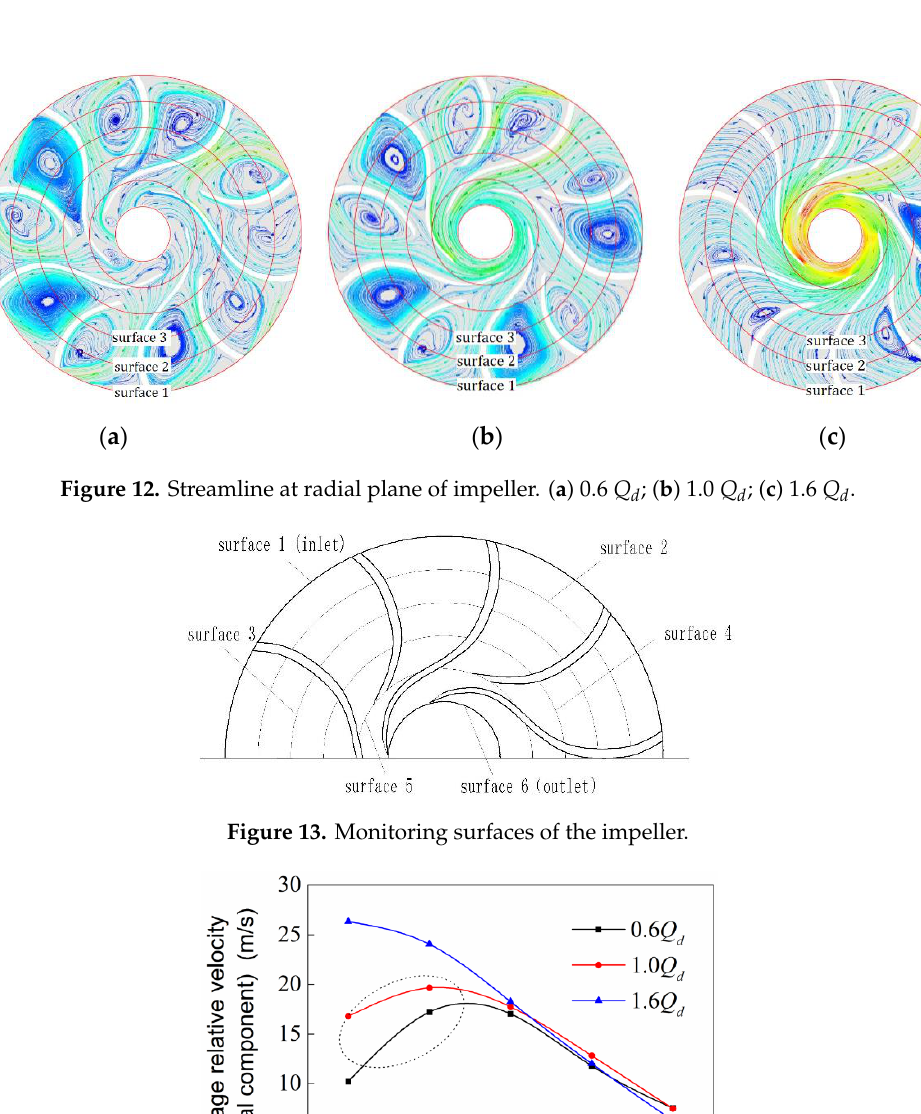
Figure 13. Monitoring surfaces of the impeller.